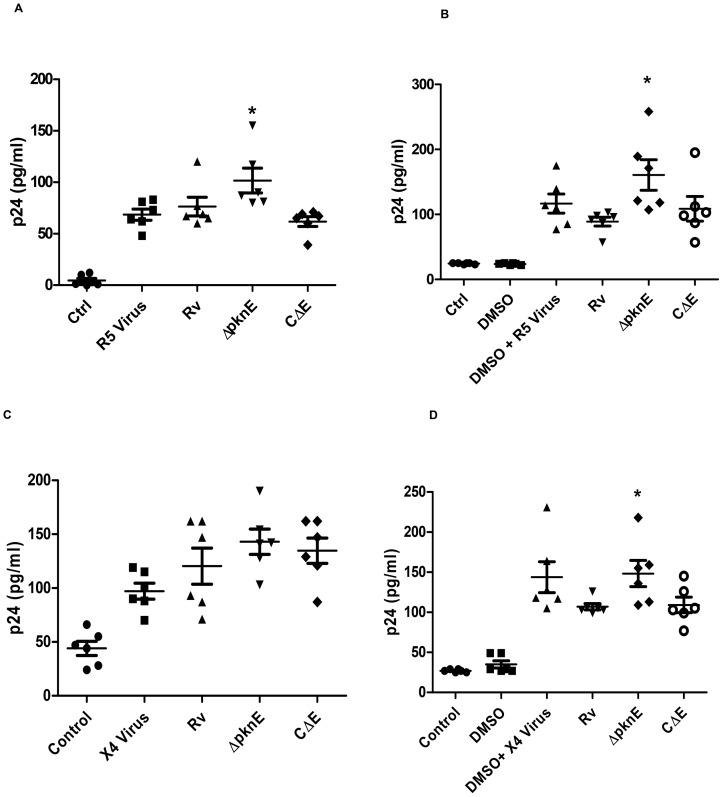
ΔpknE coinfected with CCR5 and CXCR4 tropic HIV-1 increases p24 levels in MDMs.Human monocyte derived macrophages (n = 6), were infected with M. tuberculosis strains followed by coinfection with a CCR5 tropic virus in the presence (A), and absence of SAPK/JNK inhibitor (B). Similarly, coinfection was performed using CXCR4 tropic virus in the presence (C) and absence of SAPK/JNK inhibitor (D). p24 antigen levels were estimated using ELISA on day 4. * denotes p<0.05 (one way – Anova) when ΔpknE was compared to Rv infected macrophages.